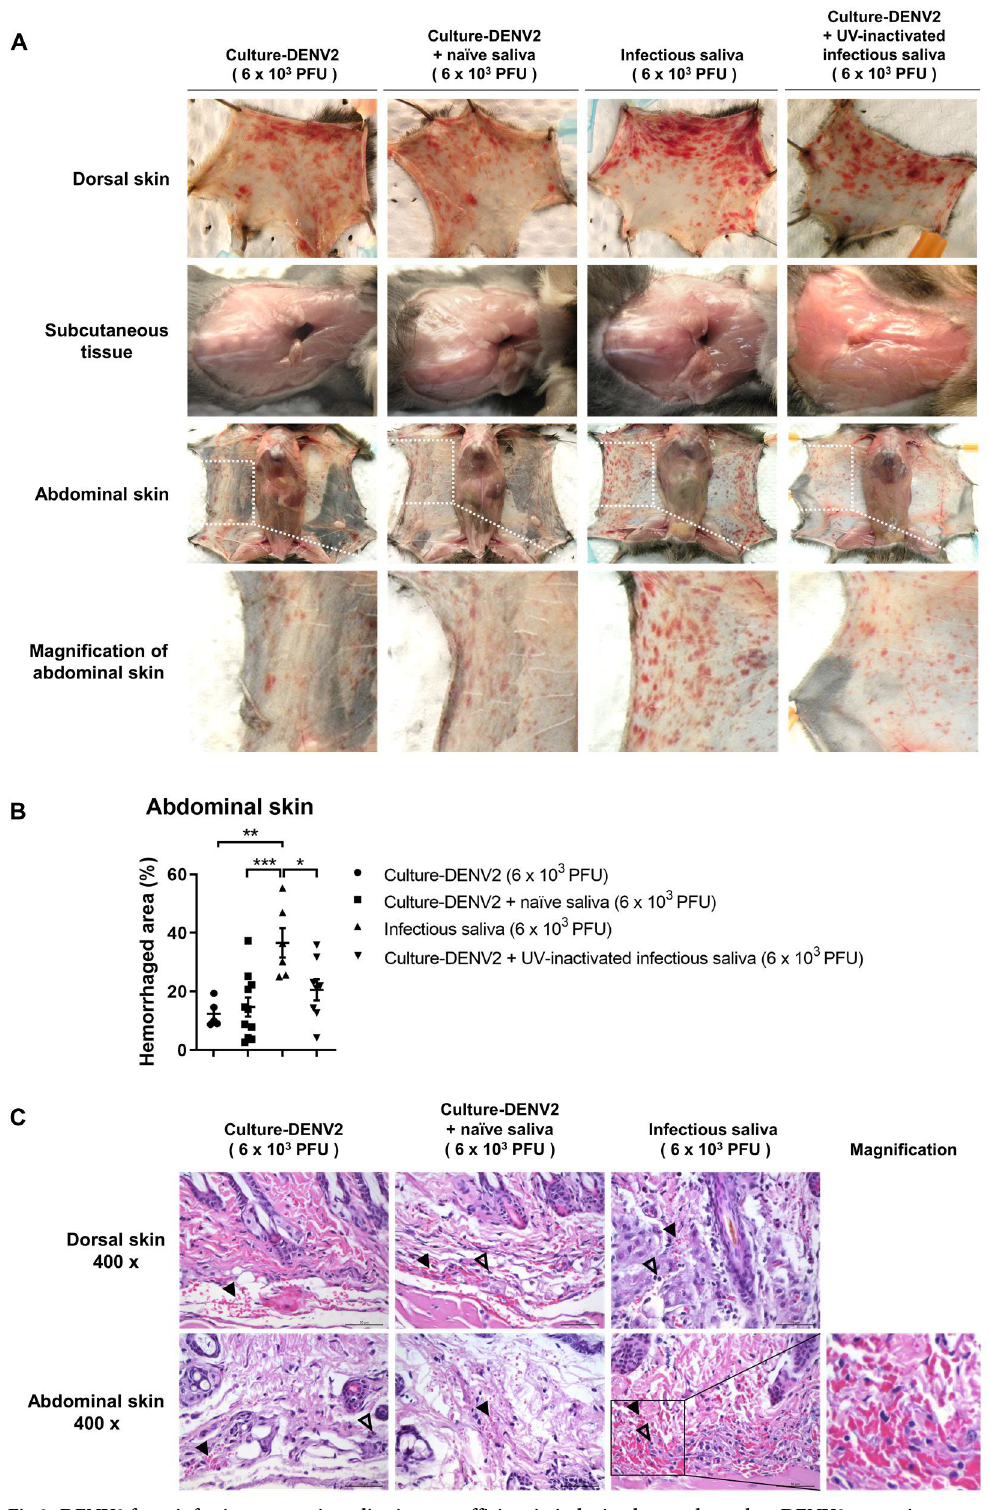
Fig 2. DENV2 from infectious mosquito saliva is more efficient in inducing hemorrhage than DENV2 grown in mosquito cell culture. Four groups of mice were inoculated with DENV2 following the protocol as described in Fig 1. (A) Mouse dorsal skin, subcutaneous tissues, and abdominal skin were dissected on day 6 after inoculation. The abdominal